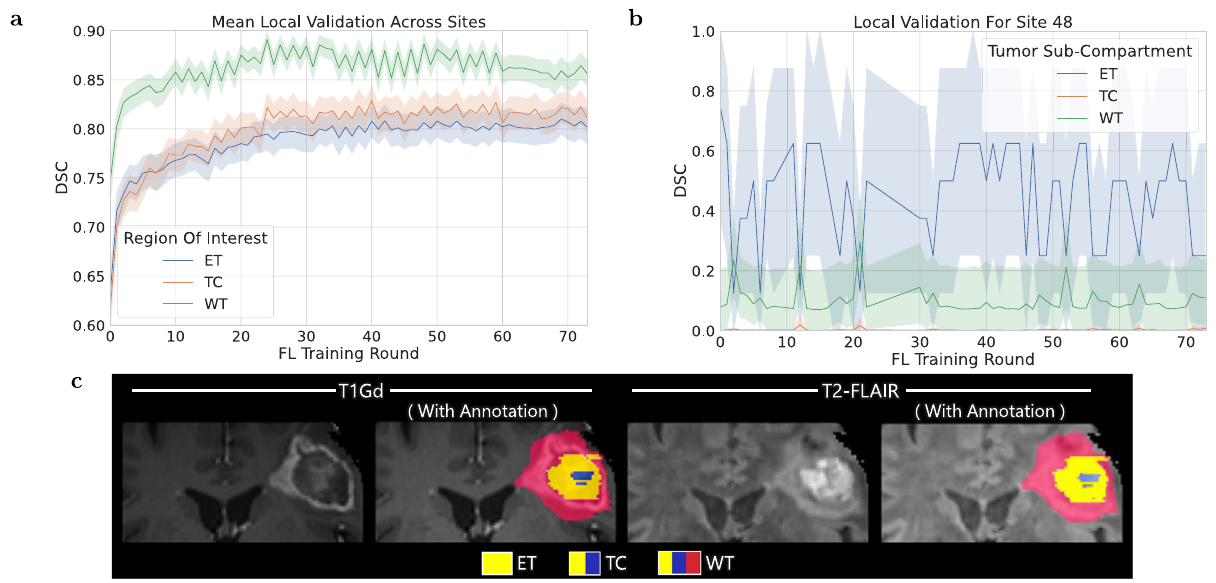
Fig. 3 | Per-tumor region (ET enhancing tumor, TC tumor core, WT whole tumor) mean Dice similarity coef fi cient ( DSC ) over validation samples (with shading indicating 95% con fi dence intervals again over samples). a At all par- ticipating sites across training rounds showing that the score is greater for sub- compartmentswith larger volumes. b Fora site with problematicannotations (Site